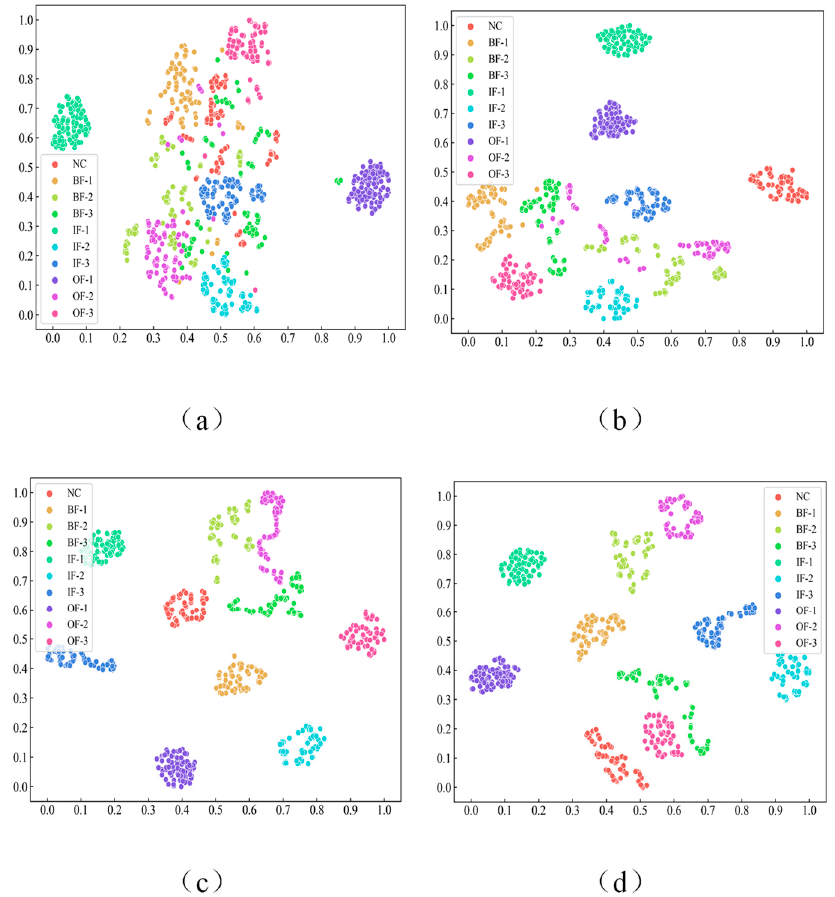
Figure 10. The t-SNE visualization results under different methods. ( a – d ) correspond to the VGGNet, Conv5, ProtoNet-10 shot, and our method-10 shot. Table 4. Comparison of time consumption of different